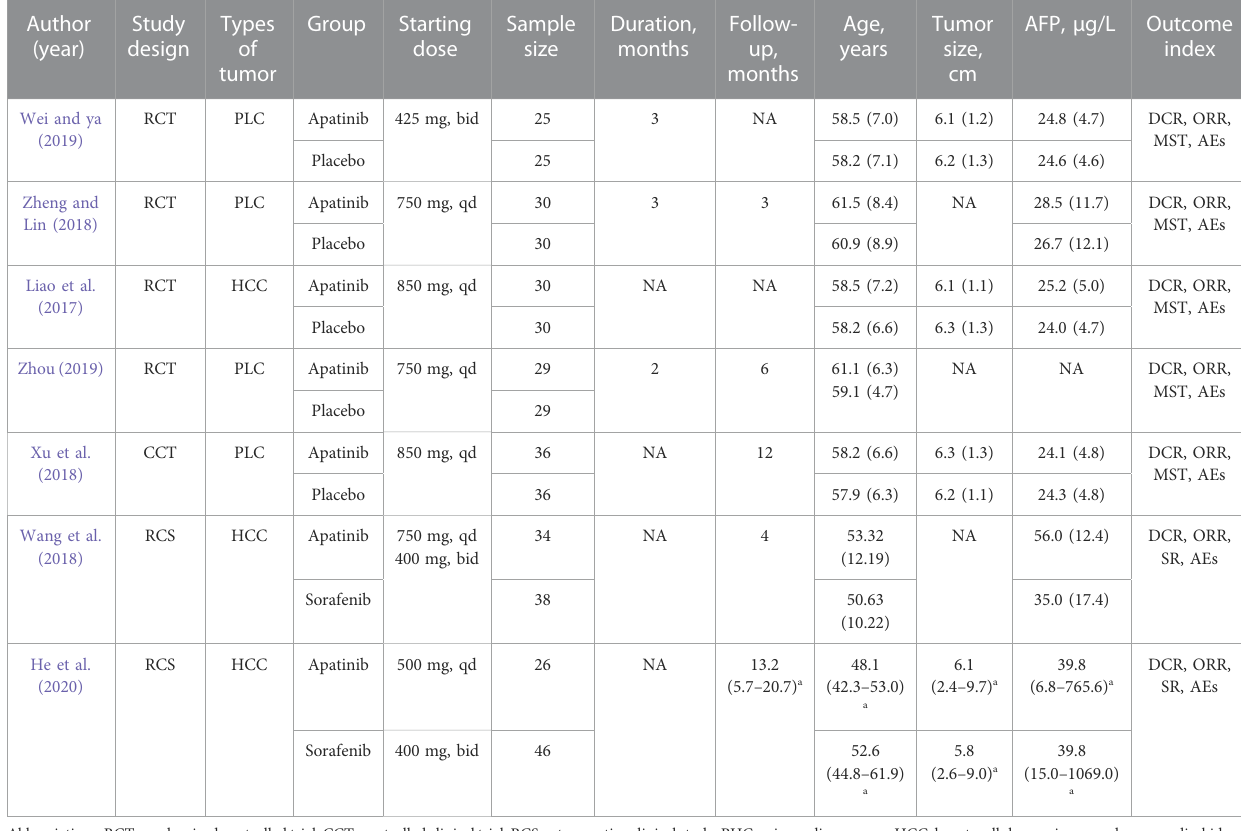
TABLE 1 Baseline characteristics of patients in the included